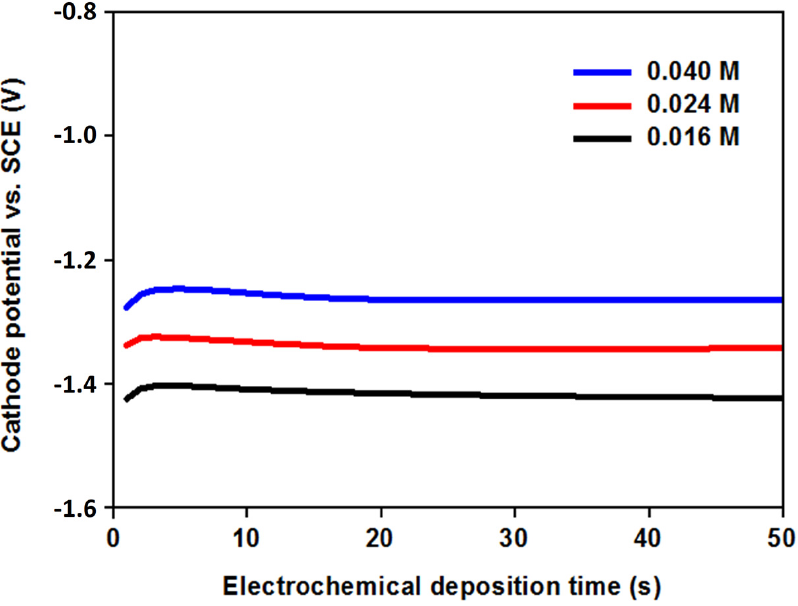
Figure 1. Potential–time transient curves of the samples electroplated at different ion concentrations of Co.